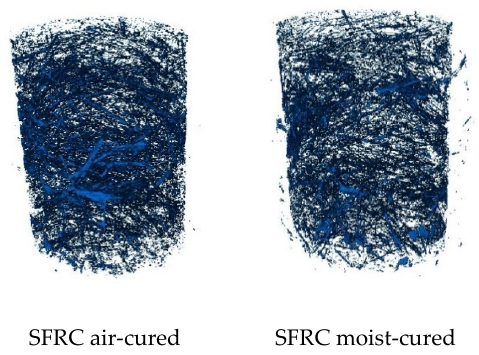
Figure 5. Three-dimensional views of the fibers belonging to different curing conditions.